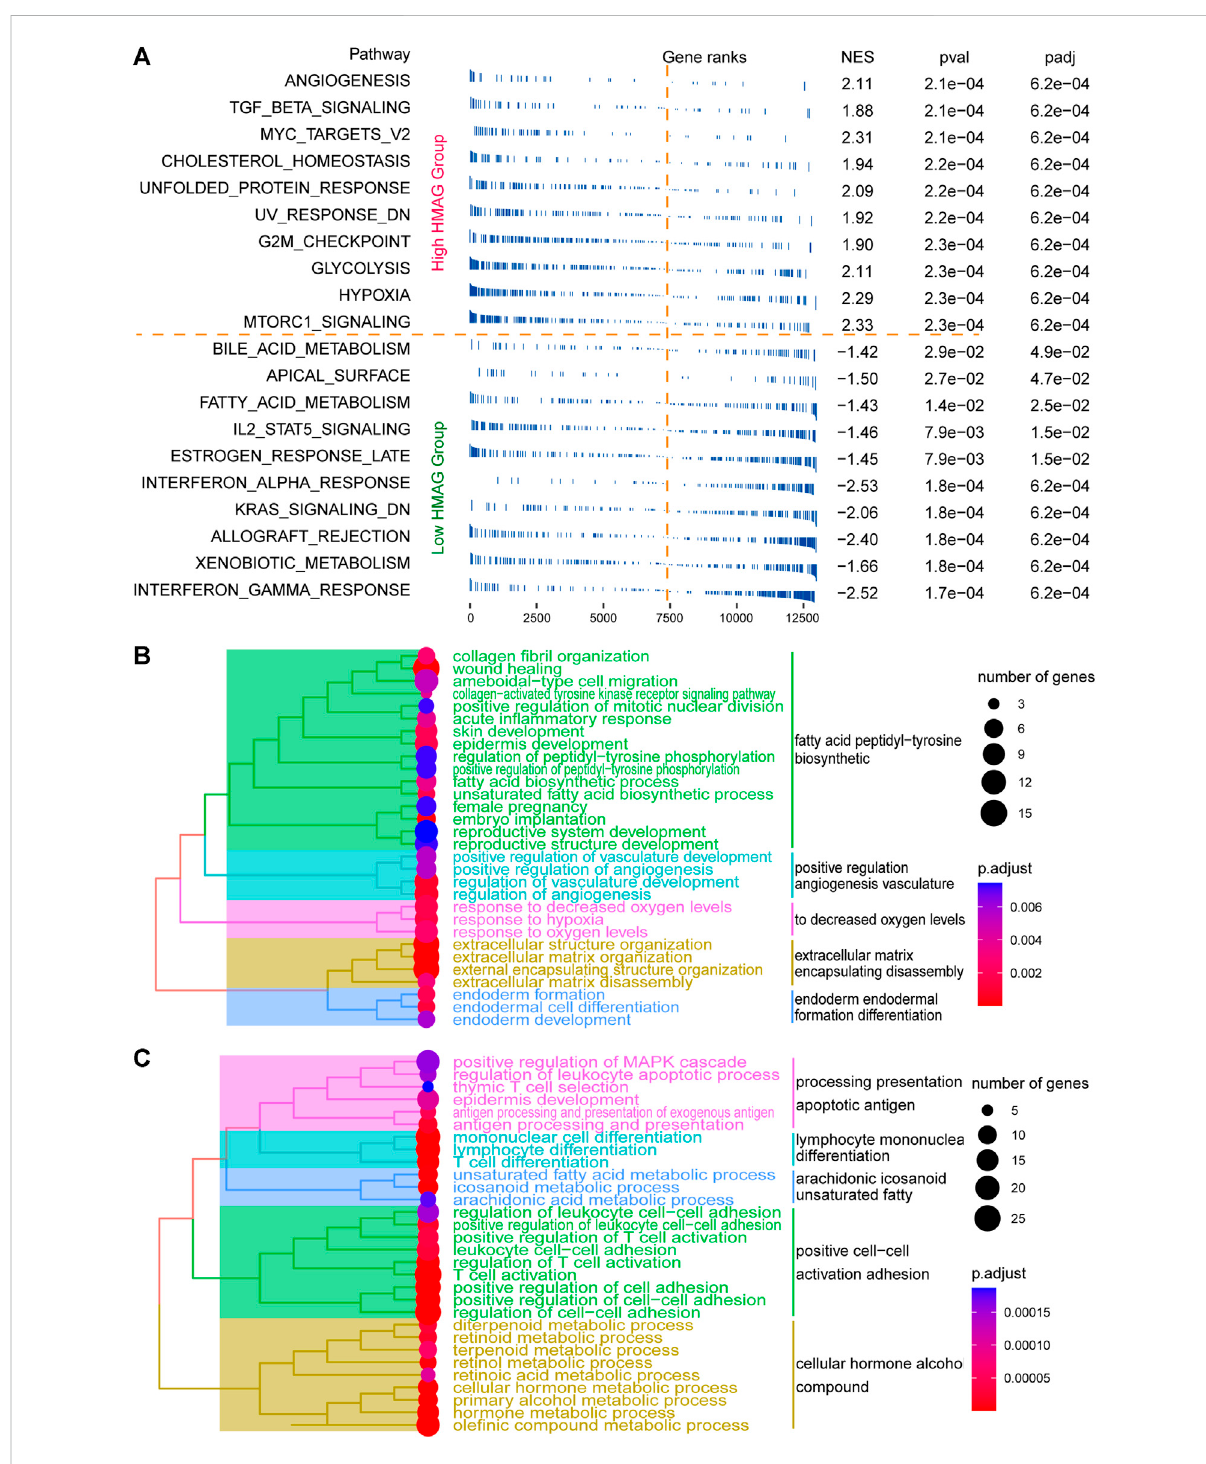
FIGURE 6 Revealing HMAG signature-regulated biological pathways. (A) fgsea showing the diverse activation of tumor biological pathways in the high- HMAG-score group and the low-HMAG-score group; (B) hierarchical clustering of enriched terms inHMAG upregulated genes; and (C) hierarchical clustering of enriched terms in HMAG downregulated